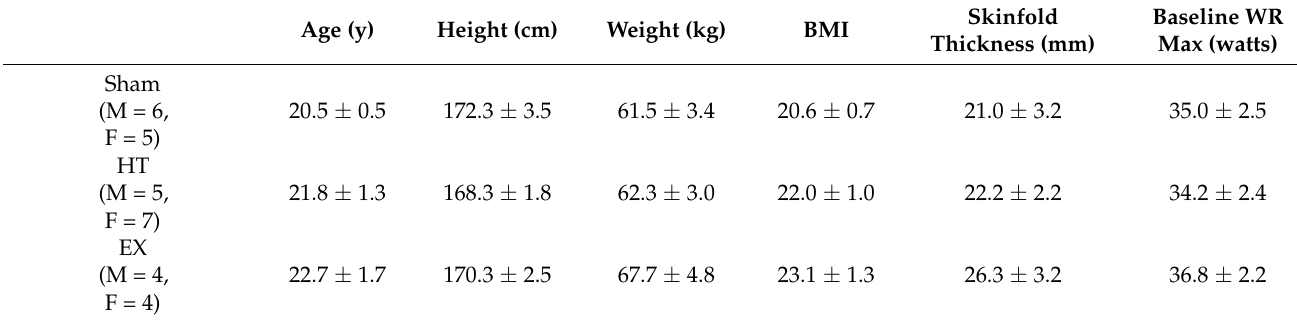
Table 1. Subject